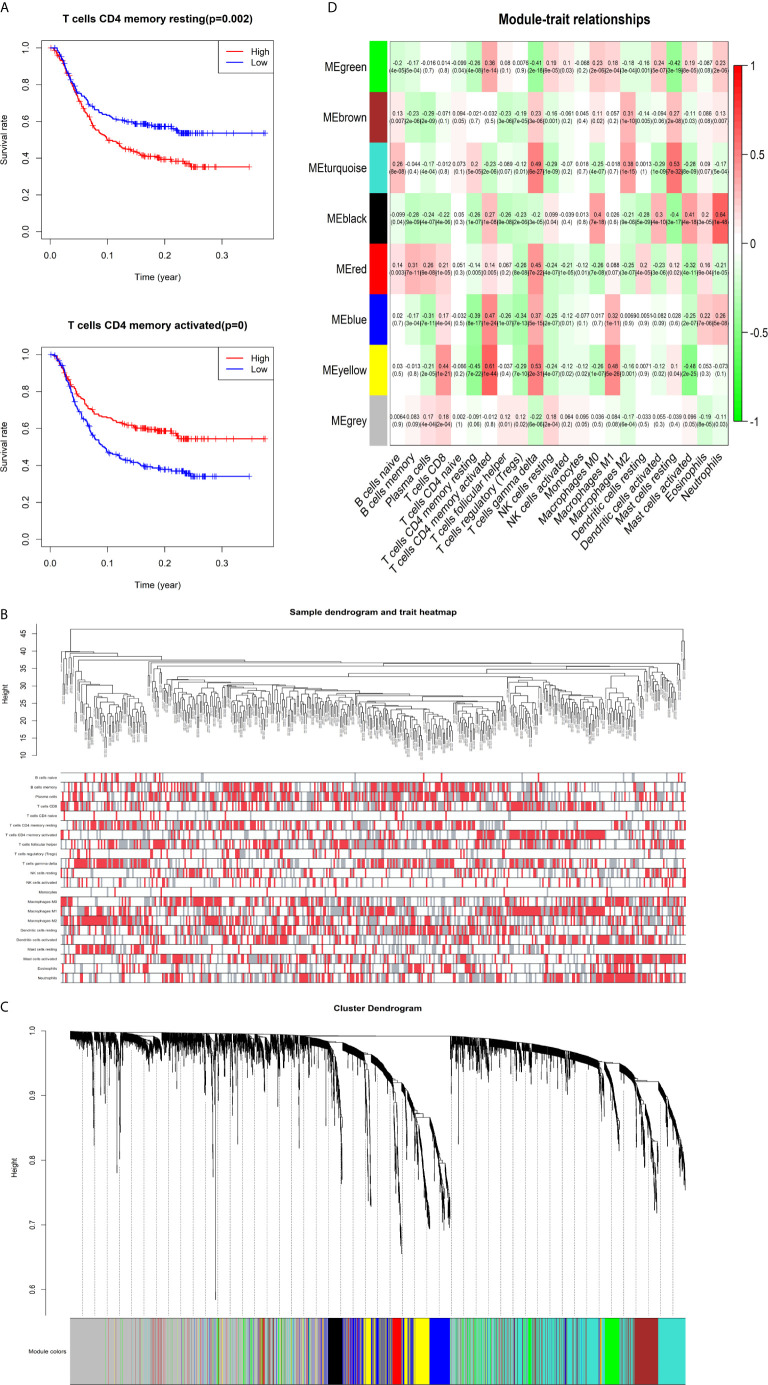
Identification of key gene module associated with overall survival (OS). (A) Kaplan-Meier survival curve of two immune cells: CD4 memory resting T cells, CD4 memory activated T cells, and M1 macrophages. (B) Sample clustering and corresponding external traits. (C) Average linkage hierarchical clustering dendrogram of the genes. (D) Heatmap of the correlation between module eigengenes and immunocytes.